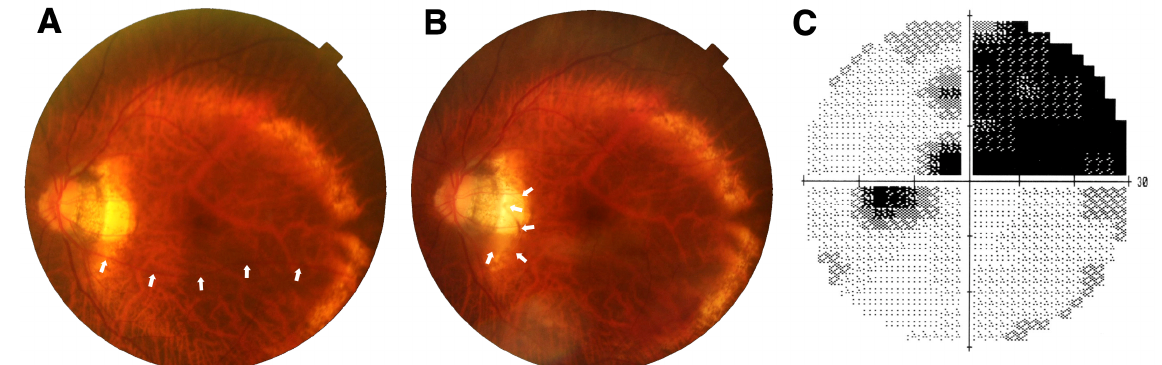
Figure 2: A) Preoperative: Path of the inferior temporal artery is indicated by white arrows. B) Postoperative: The artery (white arrows) is broken and curled up above the optic disc. C) Pattern deviation of visual field perimeter (Humphrey Field Analyzer, 30-2 program; Carl Zeiss Meditec, Inc., Dublin, CA, USA) obtained postoperatively from the patient’s left eye. The superior nasal field was